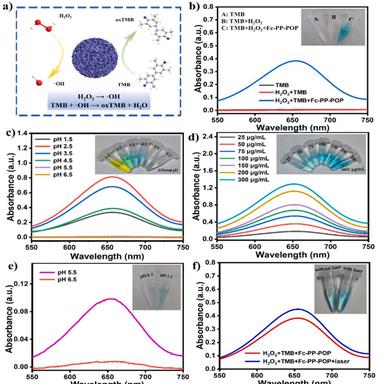
Enzyme-like activity of Fc-PP-POP. a) Peroxidase-like activity schematic diagram of Fc-PP-POP; b) UV–Vis spectra of three groups (TMB, TMB + H2O2, TMB + H2O2 + Fc-PP-POP); c) UV–Vis spectra of solutions of Fc-PP-POP (75 μg/mL) at different pH; d) UV–Vis spectra of solutions of Fc-PP-POP at different concentrations; e) UV–Vis spectra of Fc-PP-POP solutions with concentrations of 300 μg/mL in pH 5.5 and 6.5, respectively; f) Effects of 638 nm laser irradiation (1.0 W/cm2 ) for 30 s on the peroxidase-like cata